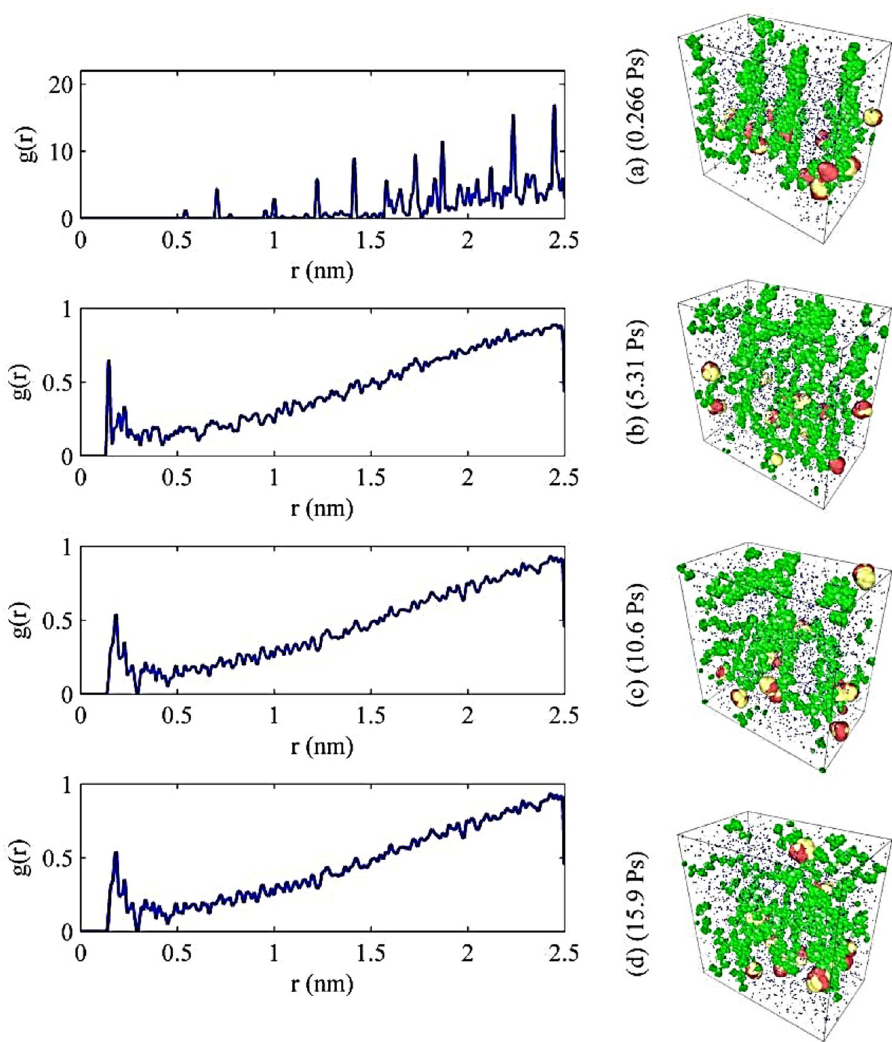
Figure 8. Radial distribution functions of sub-nanometer CuO with BA in water system.